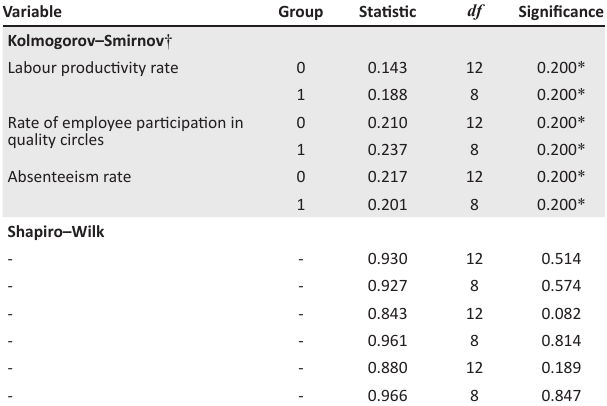
TABLE 2: Normality tests for labour productivity rate, the rate of employee participation in quality circles as well as the absenteeism rate. Variable